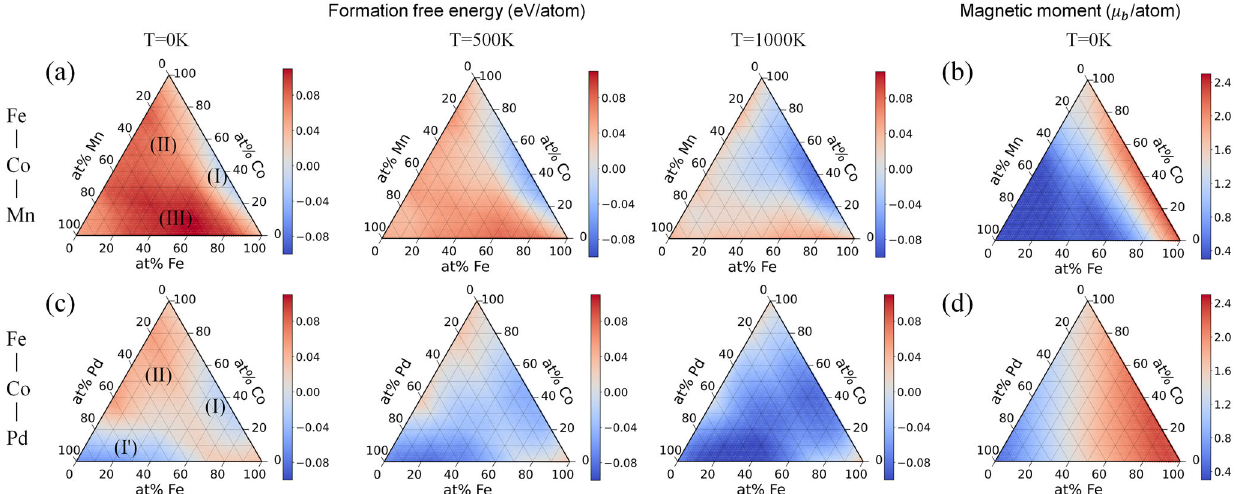
Fig. 6 Machine learning predictions of formation free energies (T = 0, 500, 1000 K) and magnetic moments (T = 0 K) for two ternary FCC solid state systems in whole concentration space. a , b Fe – Co – Mn; c , d Fe – Co –